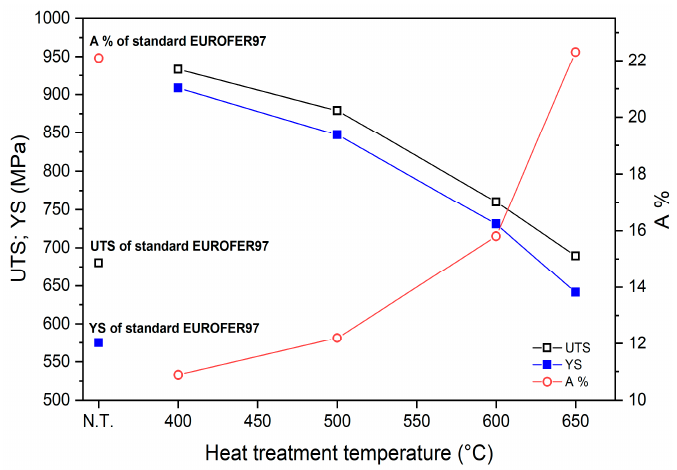
Figure 14. UTS, YS and A% of EUROFER97 steel cold rolled with CR of 80% and heat-treated at 400 °C, 500 °C, 600 °C and 650 °C for 1 h. The values of the steel prepared by standard treatment [23] are reported for comparison.